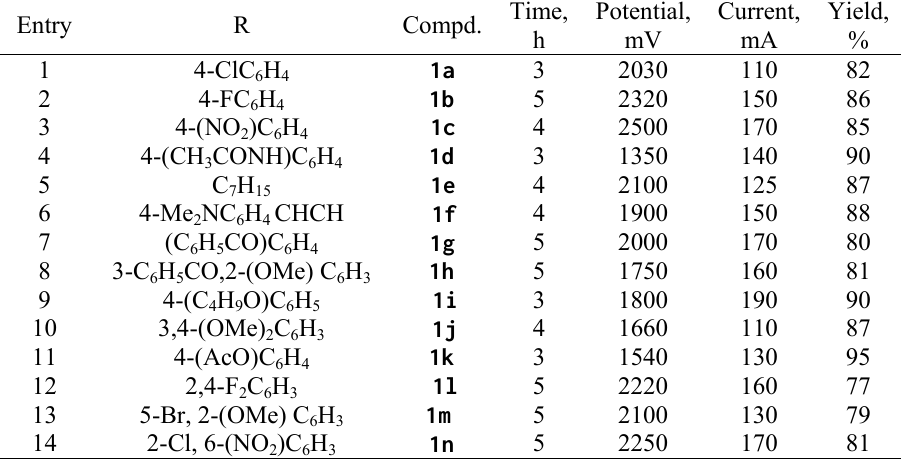
Table 1. Current, potential and yield data for synthesis of 1,3,4-oxadiazoles ( 1a-n